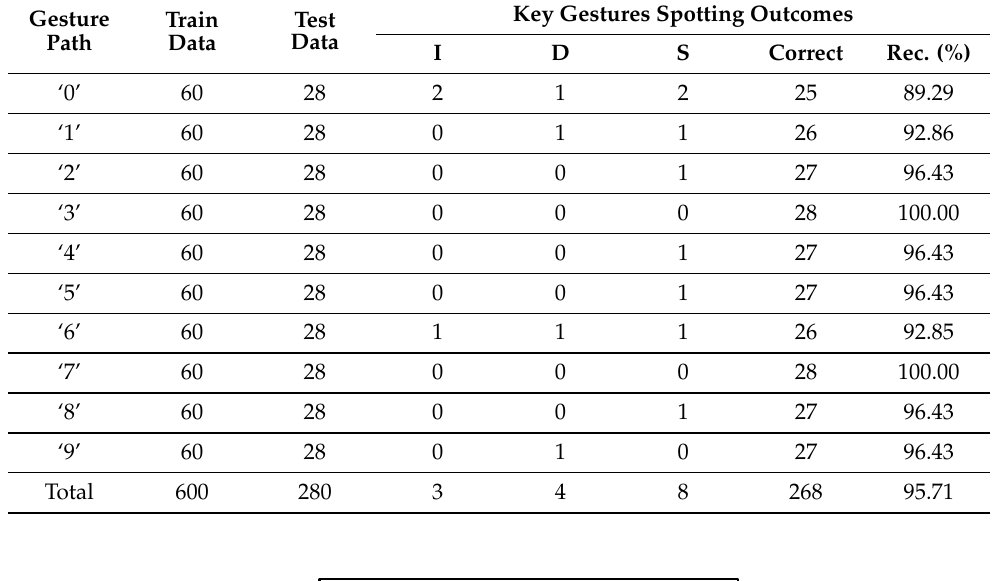
Table 1. Results of meaningful gesture spotting using HMM and recognition using DNN at Sw = 5.